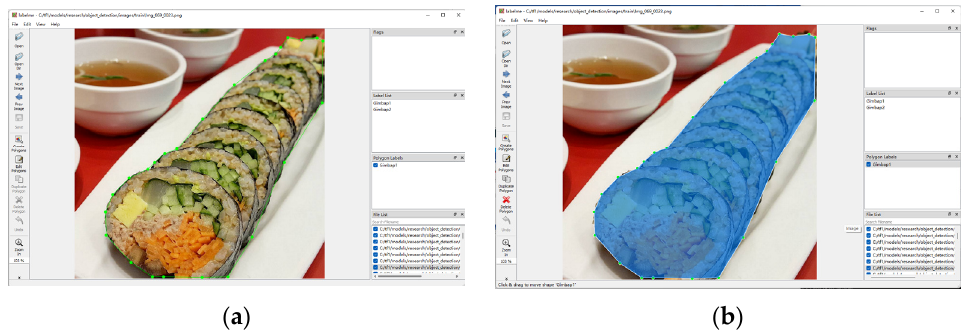
Figure 4. Label image. ( a ) Schematic Diagrams of the Gimbap Label. ( b ) Labeled Gimbap Sample. After the annotation process, the statistics of the dataset are shown in Table 1. Among the 800 training images, there are 1318 Gimbaps labeled as Gimbap1, and 655 Gimbap2 labeled as Gimbap2. There are 278 negative food items, which are food but do not belong to Gimbap. The test dataset contains 200 images. It includes 385 Gimbaps labeled as Gimbap1, 106 Gimbaps labeled as Gimbap2, and 56 negative food items.